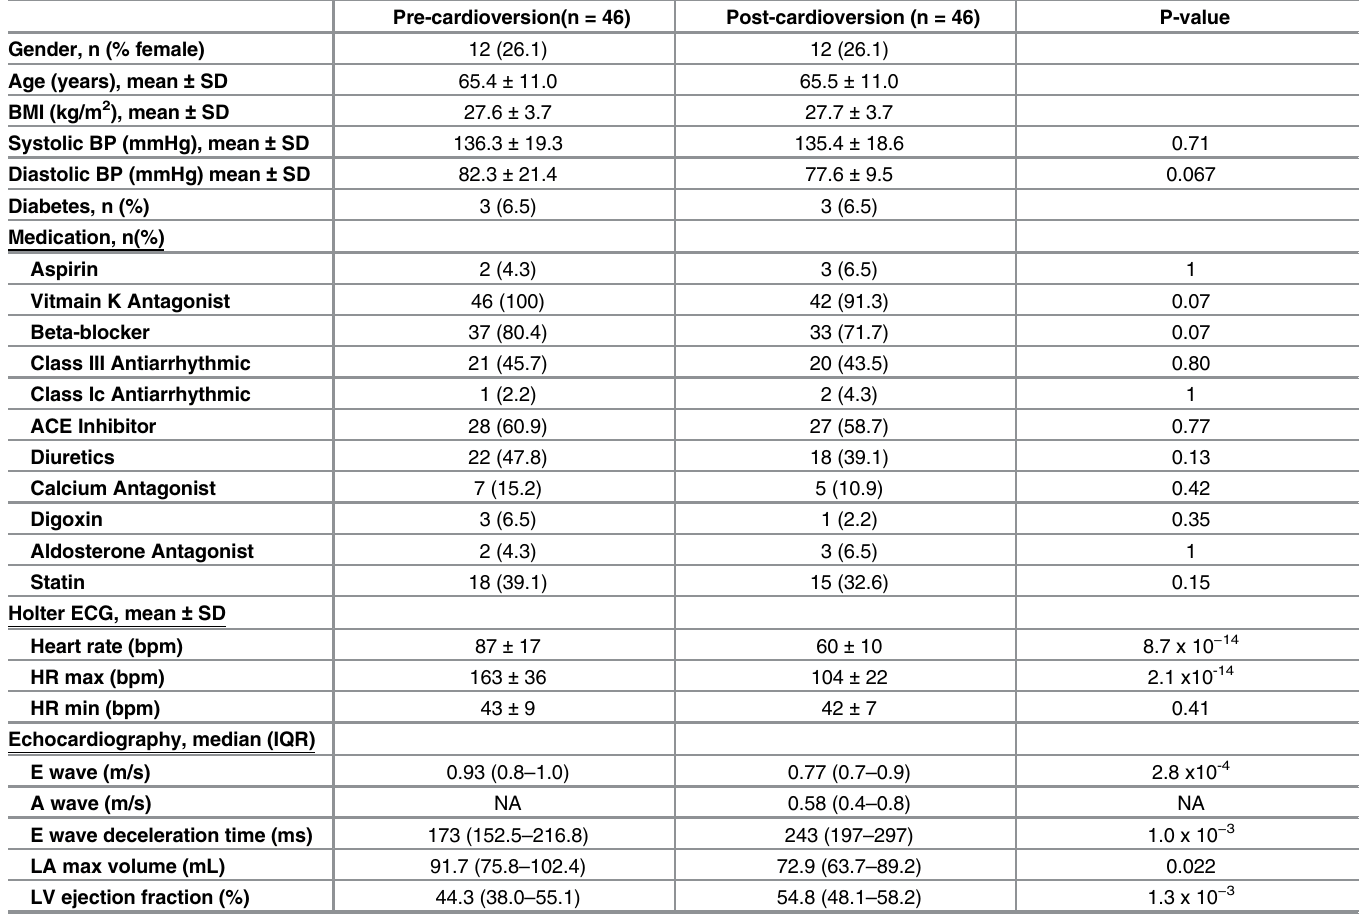
Table 1. Participant demographics for biomarker discovery